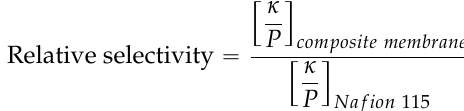
Figure 8. Diffusion coefficient ( ● ); and steady ‐ state permeability ( ○ ) of Br 2 /Br 3 ‐ in N(fibers)/PPSU nanofiber composite membrane as a function of soak time in a solution of 0.14M Br 2 in 2M HBr at 25 °C. 3.6. Bromine species (Br 2 /Br 3 ‐ ) Permeation for the Two Complementary Nanofiber Composite Membrane Structures Figure 9 shows freeze ‐ fractured SEM cross section images of N/PPSU (fibers) (Figure 9a) and N (fibers)/PPSU (Figure 9b) composite membranes, where both membranes were of the same composition (57 vol% Nafion and 43 vol% PPSU). The presence of nanofibers, either PPSU (Figure 9a) or Nafion (Figure 9b), embedded within a continuous matrix of the second membrane component